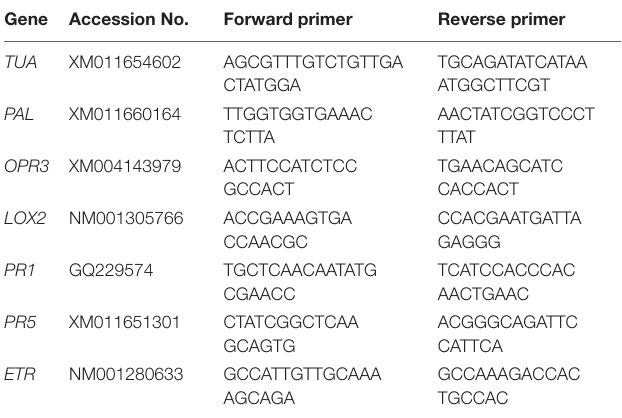
TABLE 1 | The specific primers for qRT-PCR. Gene Accession